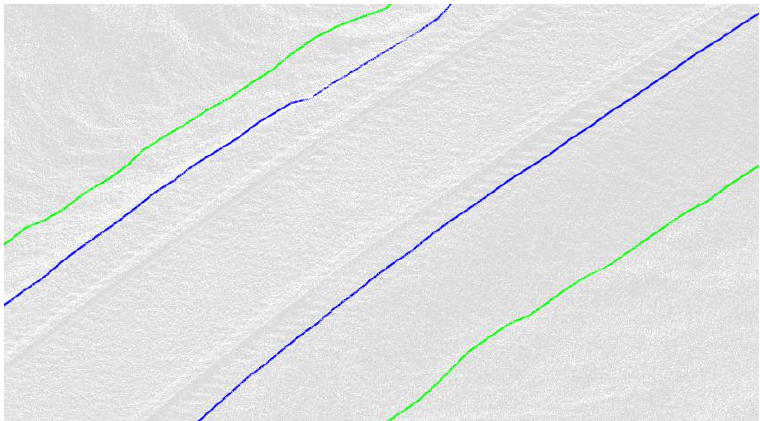
Figure 12. Resulting ballast top ( blue ) and bottom ( green ) extracted lines.